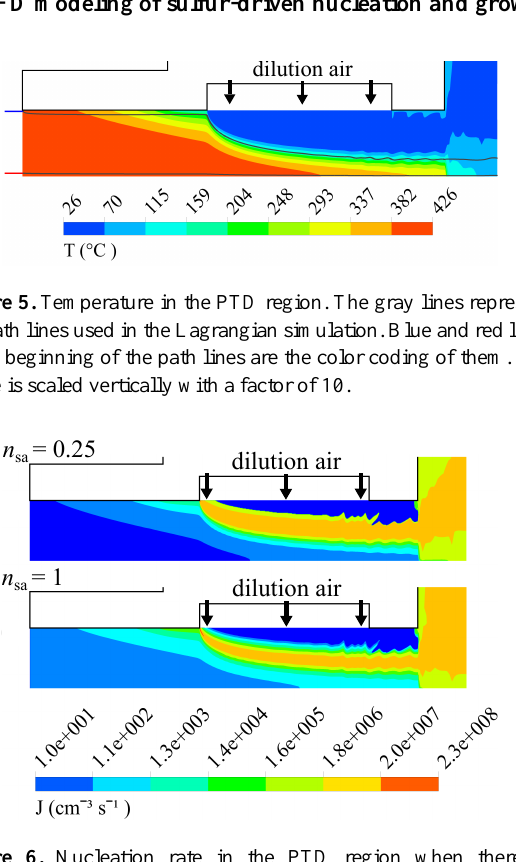
Figure 6. Nucleation rate in the PTD region when there is [ H ] = 1 . 47 × 10 11 cm − 3 in raw exhaust of R case with differ- 2 SO 4 ent nucleation exponents. The figure is scaled vertically with a fac- tor of